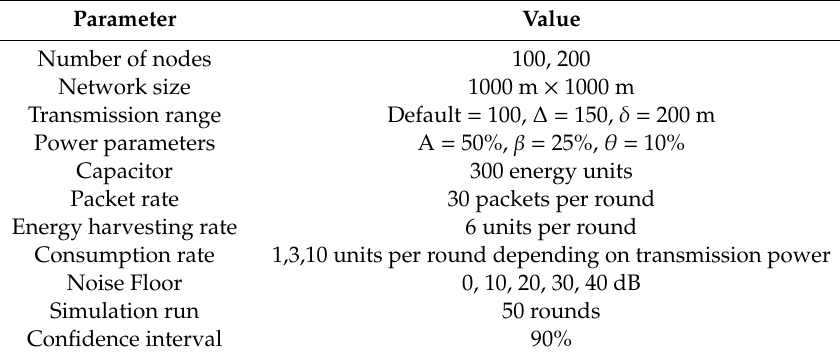
Table 1. Simulation parameters.